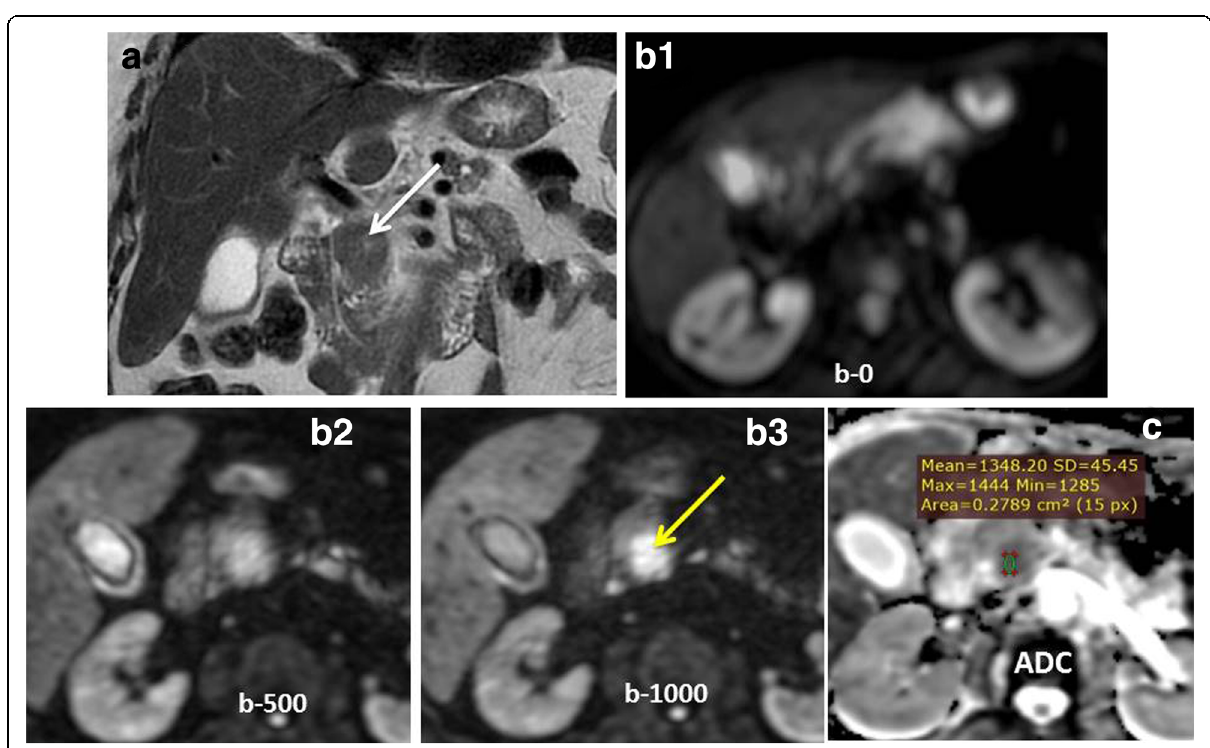
Fig. 6 A 63-year-old female patient presented by obstructive jaundice. a Axial T2WI revealed bulky pancreatic head with ill-defined iso-intense signal lesion (arrow). b1 – b3 DWI at different b values (0, 500, and 1000 s/mm 2 ) showed a well-defined restricted pancreatic head lesion with increased restriction by increasing the b value (yellow arrow at b3 ). c ADC map of the pancreas showed low ADC signal from the lesion with intermediate ADC value (1.3 × 10 − 3 mm 2 /s). The pancreatic vessels are preserved and not encased by the lesion (resectable